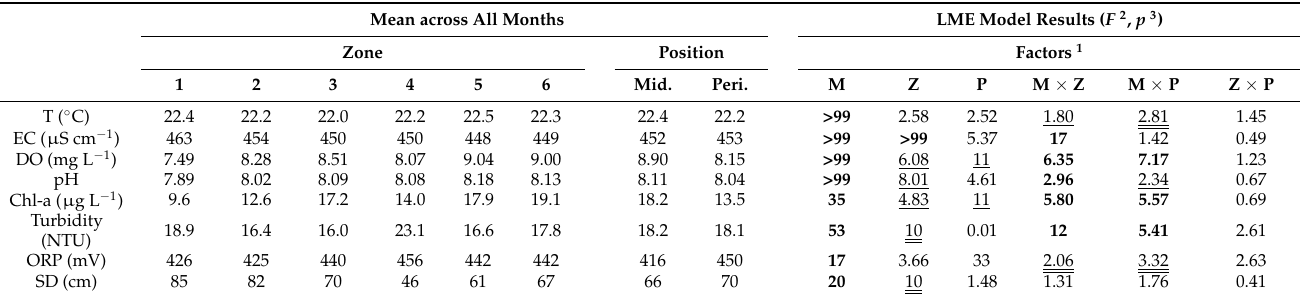
Table 1. Mean values of water quality variables at each zone and lateral position in MA, and results of linear mixed-effects model. T: temperature, SD: transparency.